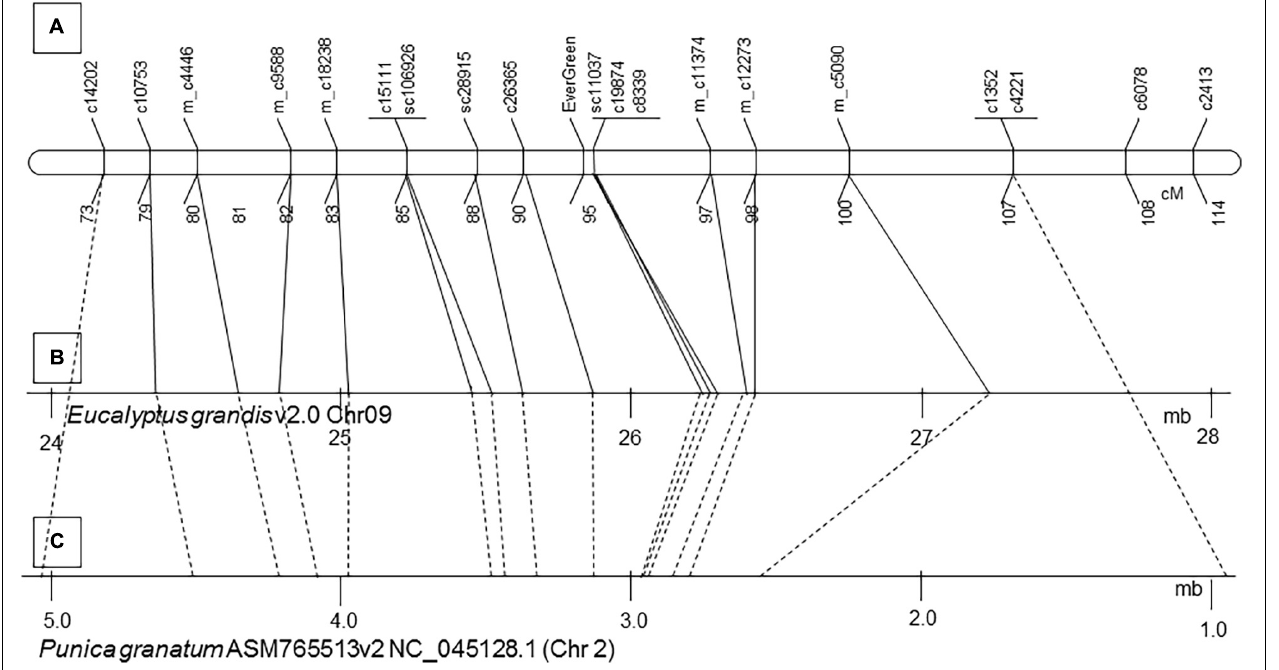
FIGURE 5 | Microsynteny between pomegranate LG3, pomegranate ’Tunisia’ genome sequence ASM765513v2 and the homologous genomic sequence of Eucalyptus grandis V1.0 chromosome 9. Twenty-seven pomegranate genes that were mapped in the vicinity of the evergreen trait at ‘P.G.160-61 × P.G.100-1’ map (A) were blasted to the Eucalyptus grandis V1.0 chromosome 9 (B) and to pomegranate ’Tunisia’ genome ASM765513v2 (C) . Continuous lines connect the mapped pomegranate genes to their position on chromosome 9 of Eucalyptus grandis V1.0. Dashed lines connect the markers to their position on NC_045128.1 of pomegranate genomic sequence